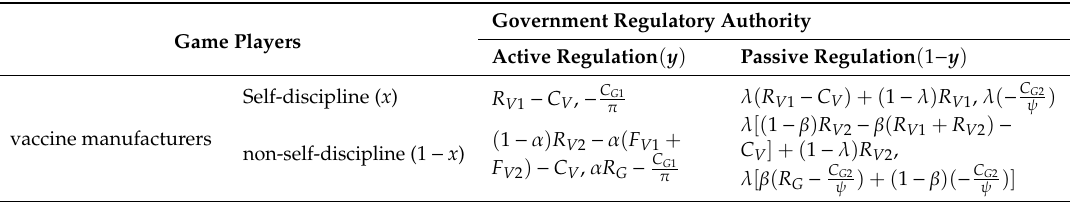
Table 2. Game payo ff